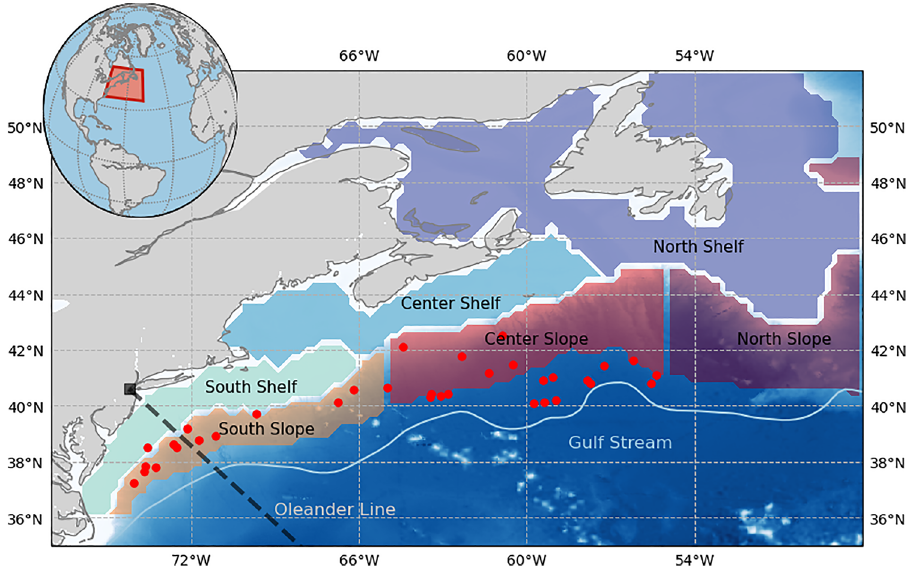
Figure 1. Map of the Northwest Atlantic. Positions of warm core rings (WCRs) on their date of absorption for the 15-month period considered here are indicated with red dots. The dashed (black) line indicates the Oleander line. The light blue line is the average path of the Gulf Stream (1993–2017). Shaded boxes are sub-regions used for marine heatwave analysis. This map was generated using Python version